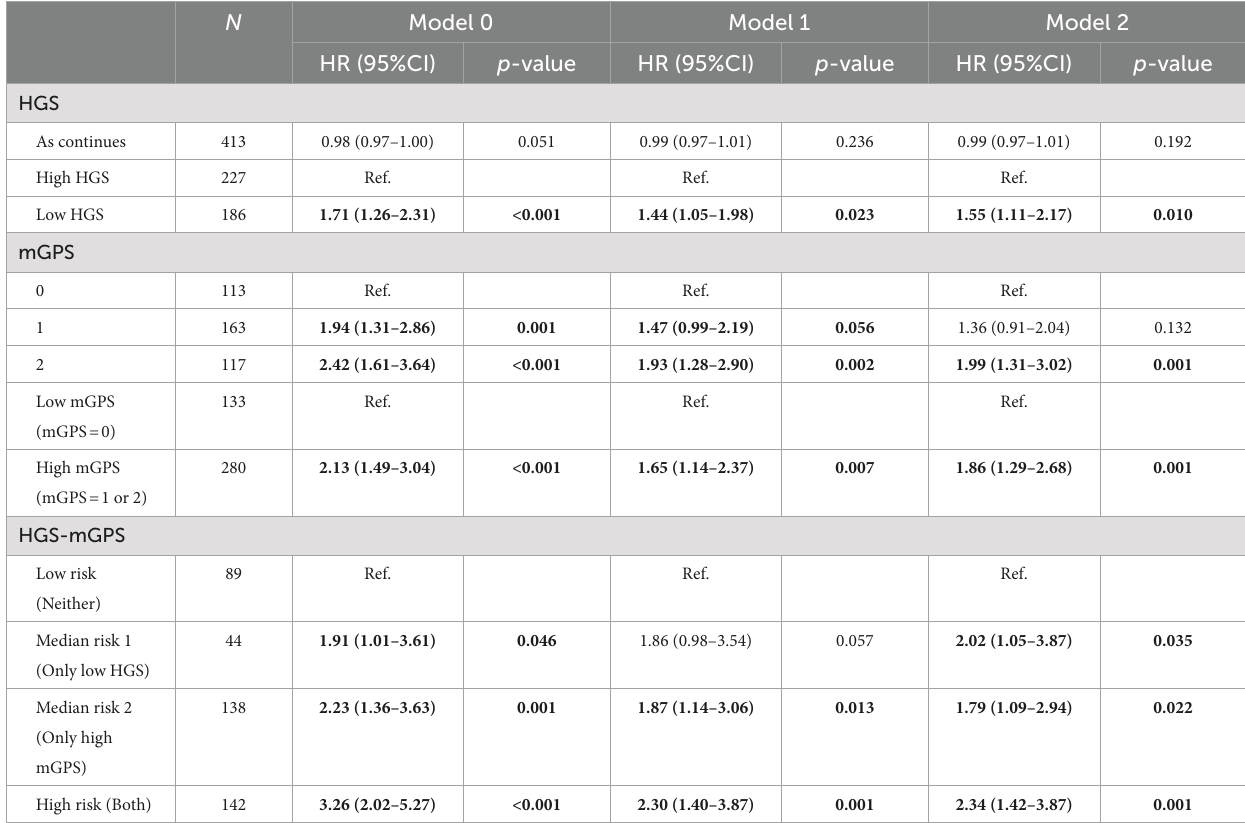
FIGURE 2 A proposed Nomogram for predicting 1 year and 5 year survival probability of patients with liver cancer. HGS-mGPS, the combination of HGS and mGPS.